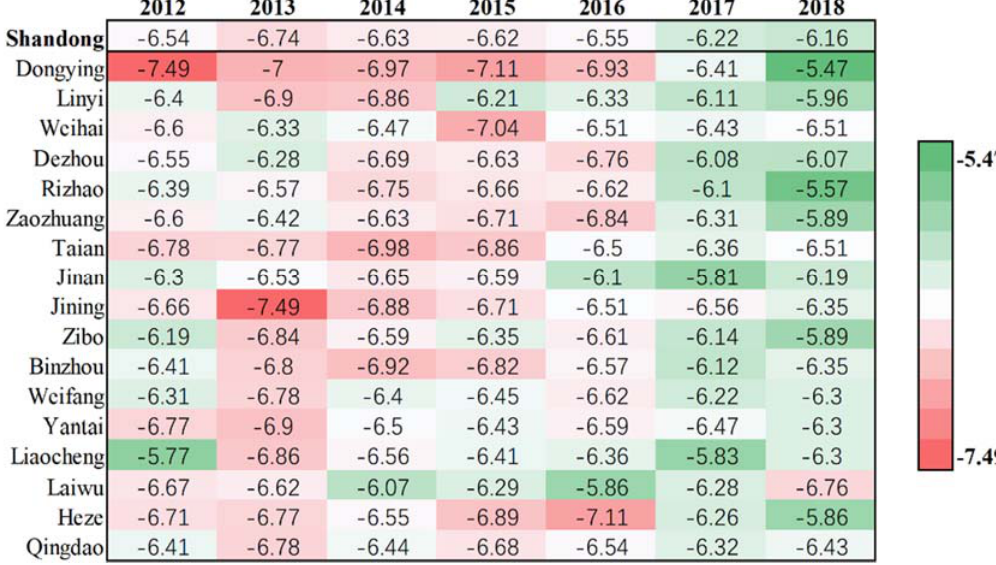
Figure 6. Analysis on the interannual change of public complaint emotional intensity of air pollution in Shandong Province from 2012 to 2018.